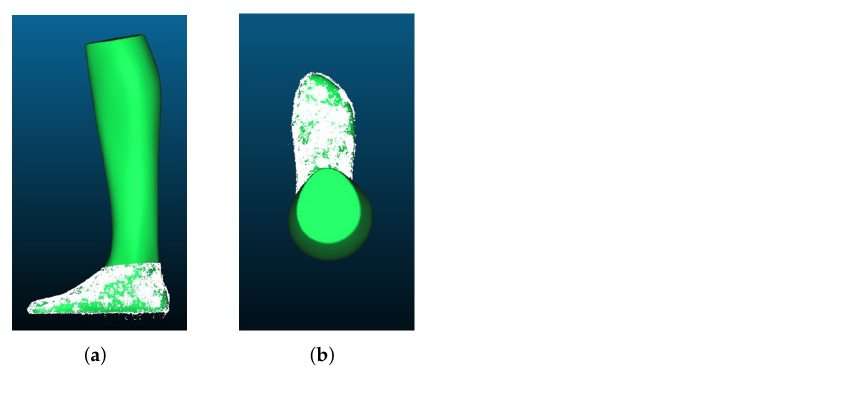
Figure 20. Point clouds recorded with an iPhone 11 Pro and processed with Agisoft Metashape: ( a ) length reconstruction; ( b ) width reconstruction.